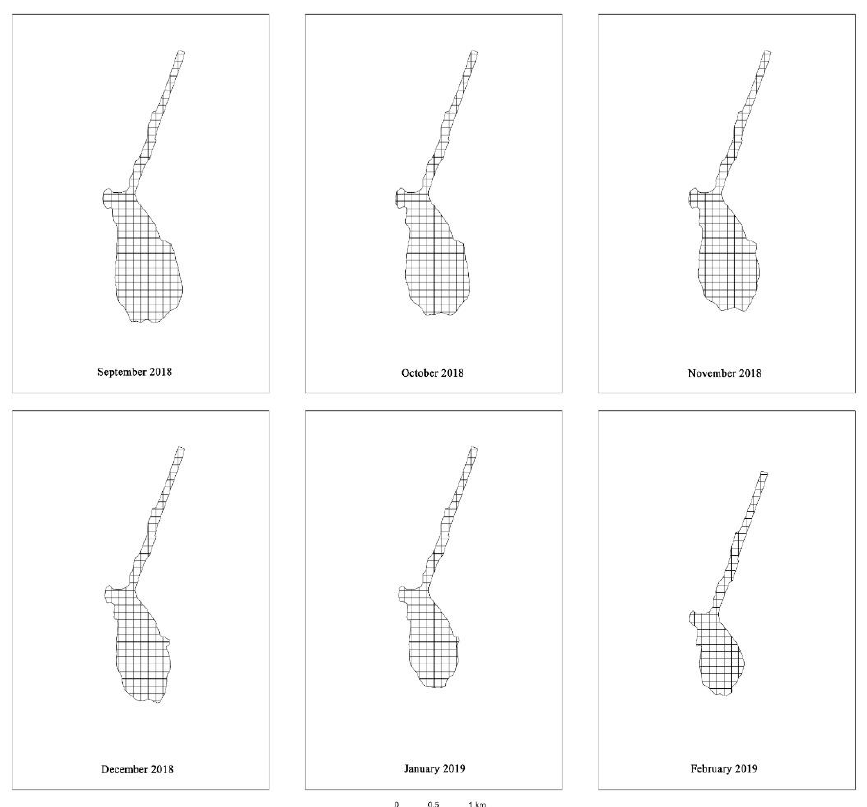
Figure A4. Areas of the Baigou Canal–Baiyangdian Lake transition zone in each month. Numeric values are provided in Table 4.